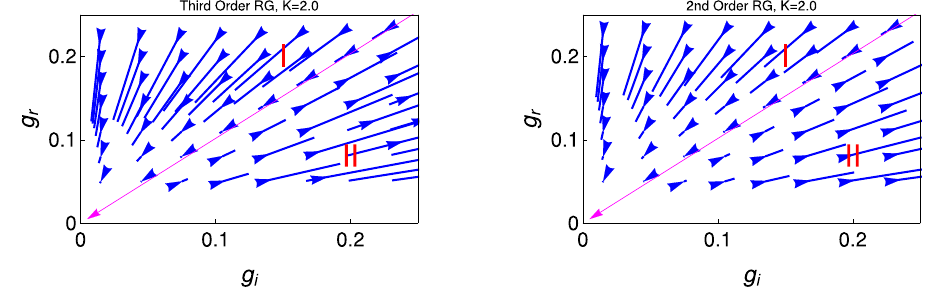
Figure 2. These figures show the behaviour of renormalization group flow lines for the couplings g r and g i , for the initial value of K ( = 2 ) . The left and right figures are for the third order (Eq. 5) and second order (Eq. 4) RG equations solutions. We mark the regions of RG flow lines into two region, I and II. The region I and II are the PT symmetry preserve and broken phases respectively. Magenta colour with arrow is the line of separatrix between the PT symmetry and PT symmetry broken phase. The BKT and PT phase boundaries coincide at K = 2 .